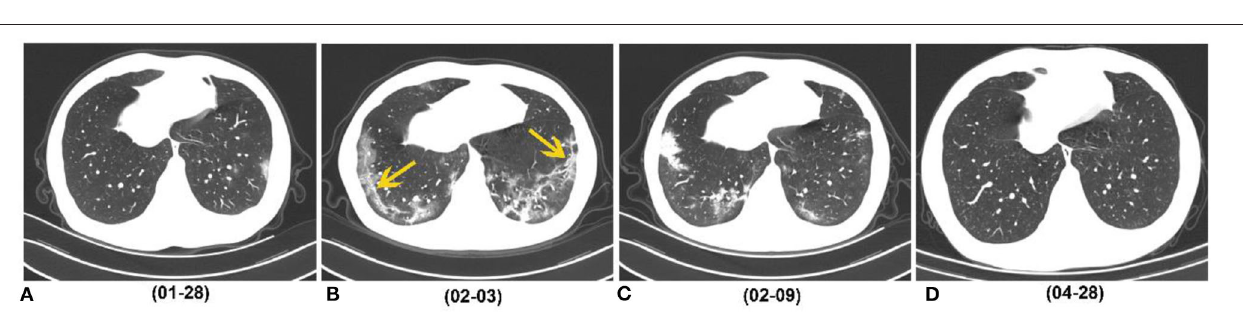
FIGURE 5 | A 29-year-old man who caught a fever on January 23, 2020, received three follow-up scans after the initial chest CT. (A) Initial CT performed on January 23 (the day of symptoms onset) showed patchy GGO in the left lower lobe. (B) Chest CT performed on February 3 showed consolidation, GGO and strip-like lesions (easily misdiagnosed as fibrosis) in the bilateral lower lobes (yellow arrow). (C) Chest CT performed on February 9 showed strip-like lesions disappeared, and multiple GGO and consolidation presented in the bilateral lower lobes. (D) On April 28 (116 days after symptoms onset), CT image showed that all lesions were absorbed. COVID-19, coronavirus disease 2019; GGO, ground-glass